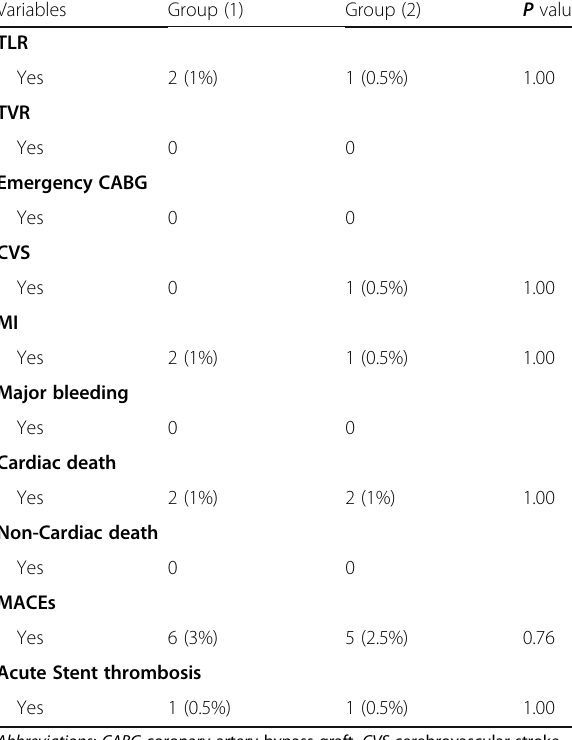
Table 5 Clinical outcomes of 24-hour hospital stay follows up Variables